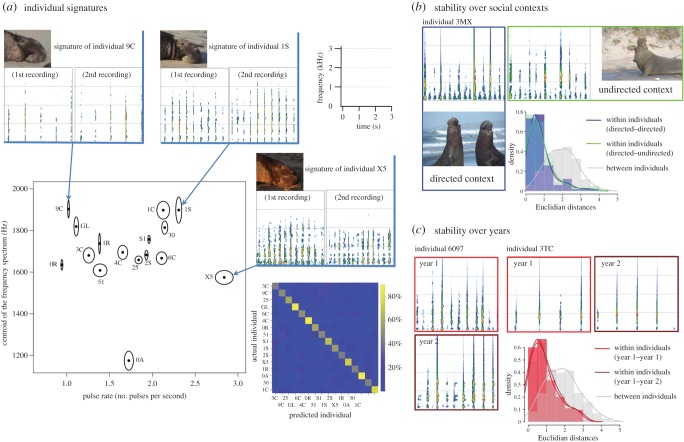
Individual signatures of the acoustic displays of male northern elephant seals. (a) As shown by the central graph and accompanying spectrograms on the sides, calls can be reliably assigned to individuals using two acoustic parameters (mean±s.e.): the centroid of the frequency spectrum and the number of pulses per call (the two main factors that separate individuals on the first discriminant function of the cross-validated DFA). The confusion matrix provided is obtained from the cross-validated DFA. It shows by colouring cell (i,j) the conditional probability of guessing that the test call came from individual j when in fact it was emitted by i. The yellow diagonal of the matrix underscores the high probability of correct classification (average=61.3% versus chance=6.3%, see text for details), highlighting the strength of the individual signatures. (b) Both spectrograms illustrate the consistency of an individual's calls in two different social contexts (calling alone and calling to a rival). The distribution of the Euclidian distances (density curves) underscores the similarity of calls within and between contexts (in the two-dimensional space defined by the calls' frequency centroid and the pulse rate; n=8 individuals, 2–6 calls individual−1, see Material and methods). (c) Both pairs of spectrograms illustrate the consistency of an individual's calls over successive years. The distribution of Euclidian distances (density curves) shows the remarkable proximity of calls within and between years (n=10 individuals, 5–6 calls individual−1 year−1). The calls represented by spectrograms in the figure are available as electronic supplementary material, audio S1.